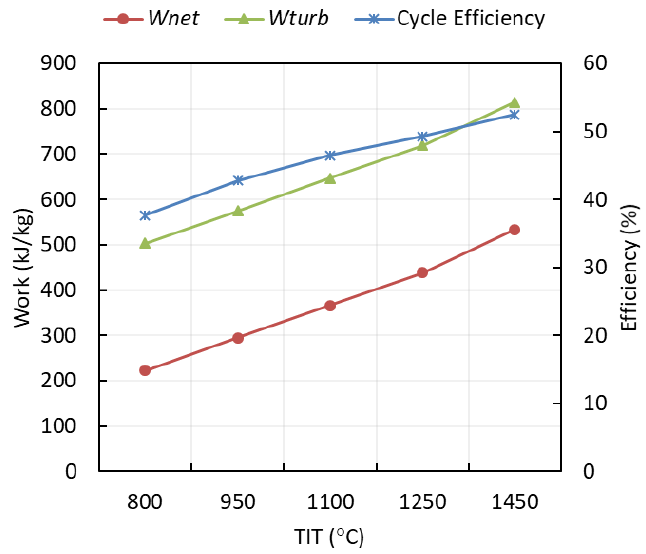
Figure 17. Variation of different parameters with the TIT.